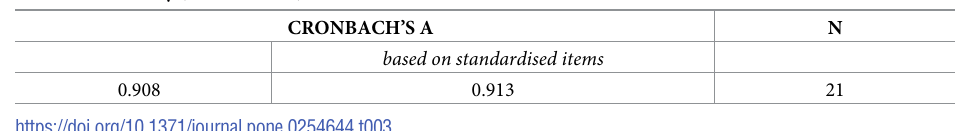
Table 3. Reliability (Cronbach’s α ).